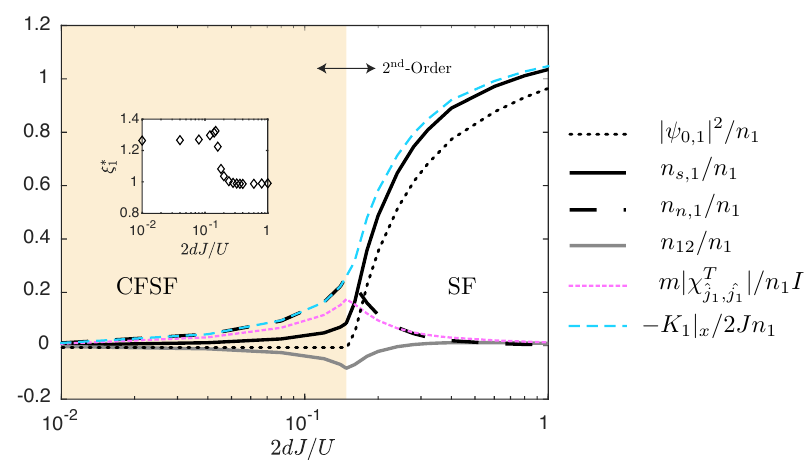
Figure 11: Transport quantities in two dimensions across the CFSF-to-SF second- order edge transition, traversed at fixed chemical potential µ/ U = 0.5 for / U = 0.9, corresponding to the n = 1 CFSF lobe in Fig. 1(b). The one- U d 12 component filling n includes the corrections of the second-order quantum fluctu- i ations. The tan-shaded area indicates the MI region. Thick black and grey lines indicate the QGW predictions for the superfluid density n and the superfluid drag s ,1 n respectively, while the black dashed and dotted lines refer to the normal com- 12 | 2 . Pink dotted and blue dashed lines are ponent n and condensate fraction | ψ n ,1 0,1 | the contributions to n from the average kinetic energy K and the intraspecies s ,1 i x current response function χ T , respectively. (Inset) Renormalization of the effective ˆ j ,ˆ j i i mass across the CFSF transition due to the collisionless